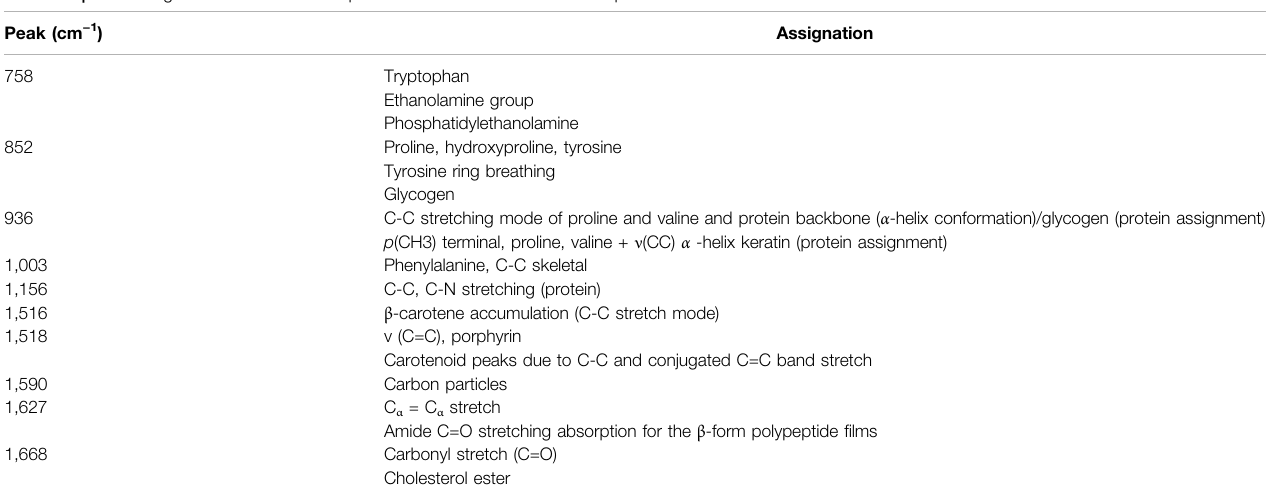
TABLE 2 | Peak assignments in the Raman spectra from follicular fl uid of PCOS patients. Peak (cm − 1